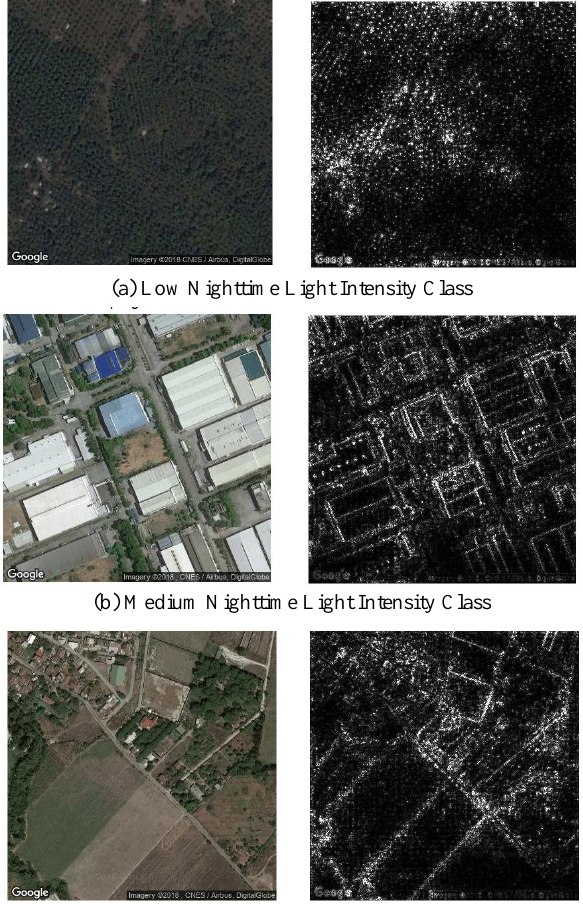
Figure 5. Class saliency maps for test satellite images in the nighttime light classification task. Maps were generated using a single back-propagation pass through the trained